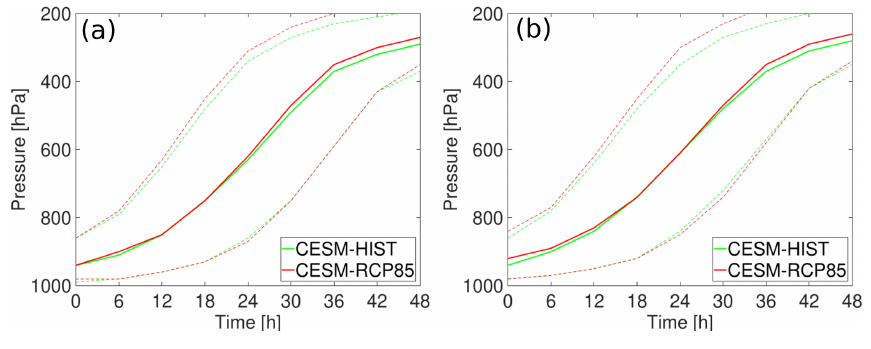
Figure 6. Time evolution of pressure (in hPa) along all WCB trajectories in (a) boreal winter and (b) boreal summer. Solid lines denote the mean over all trajectories and dashed lines the 10th and 90th percentiles for HIST (green) and RCP8.5 (red).